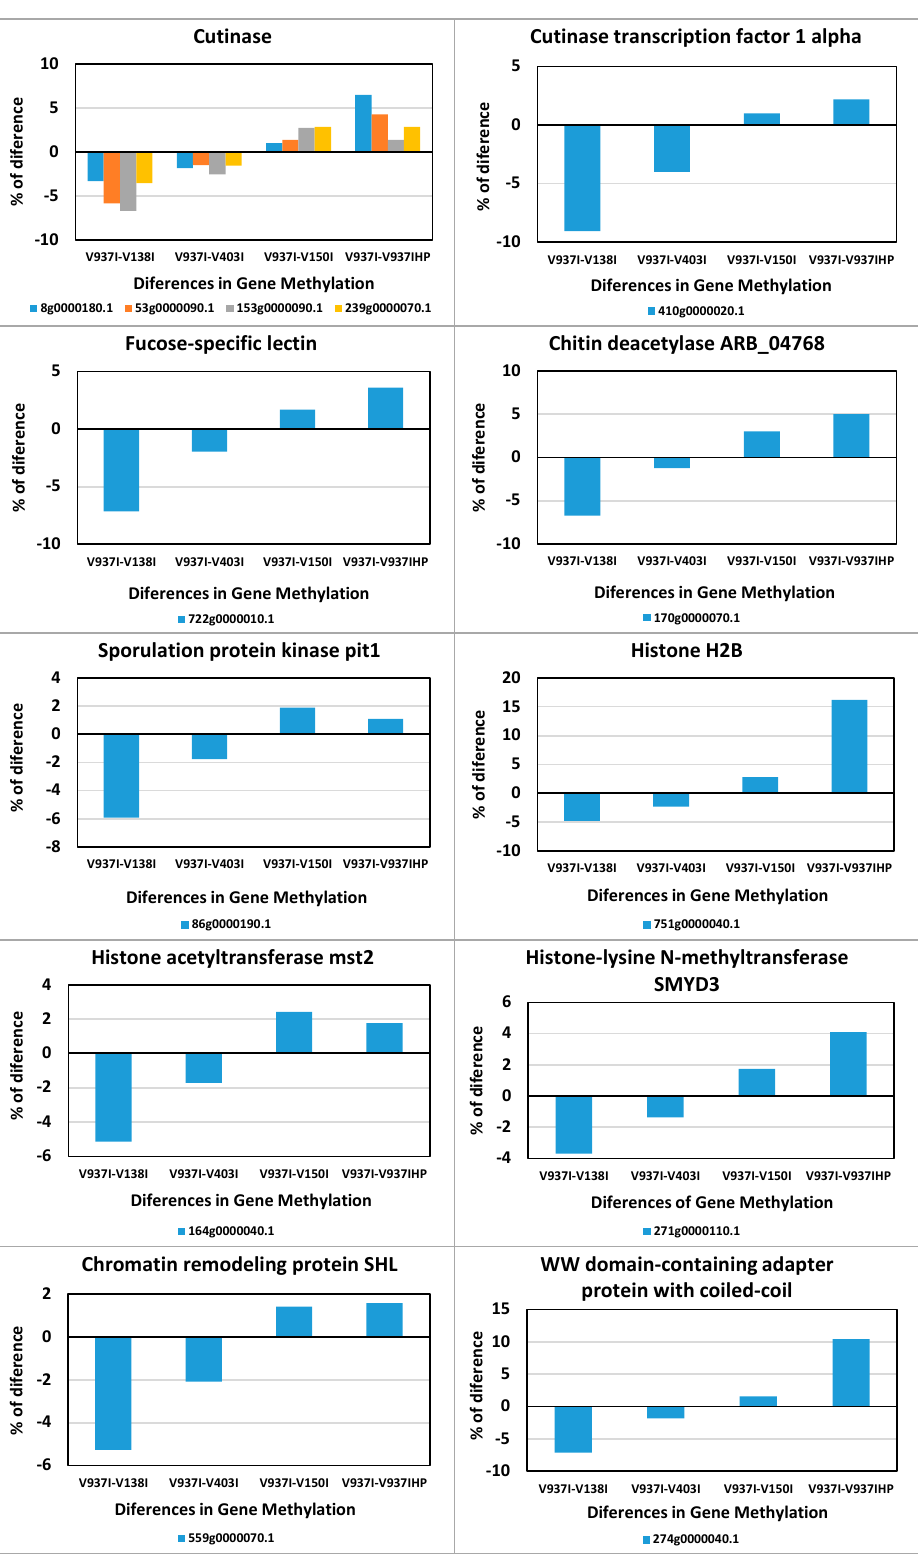
Figure 7. Differences in methylation of some of the genes involved in pathogenicity, sporulation, or chromatin condensation. The differential methylation profiles of some of the 831 selected genes involved in relevant processes are represented.